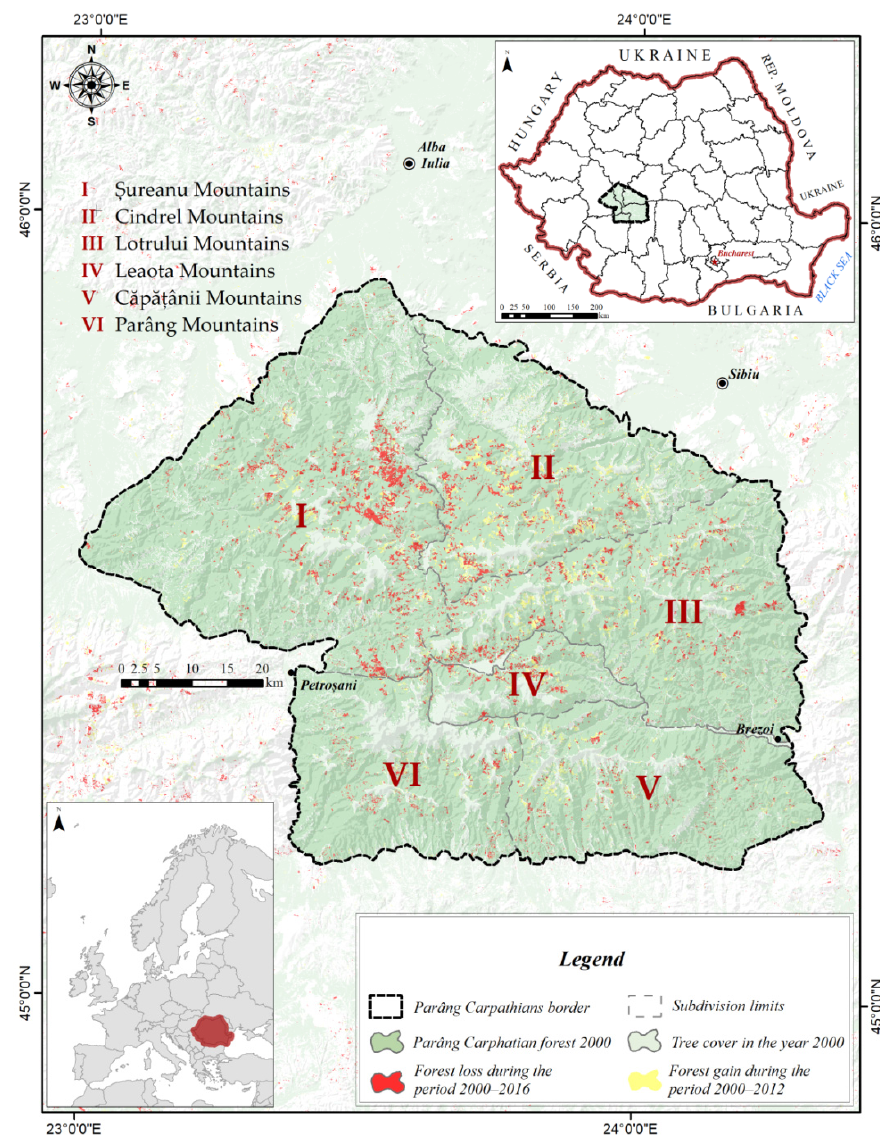
Figure 1. The geographic position of the Parâng Mountains.